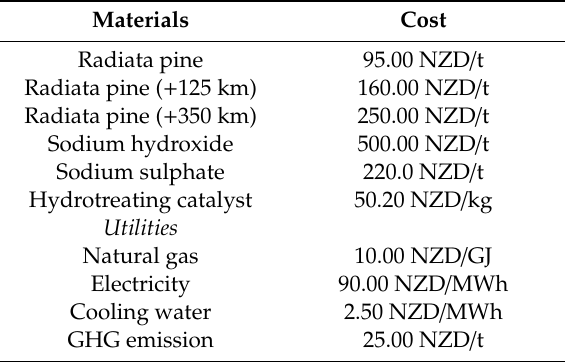
Table 1. Estimated material, utility, and carbon emission prices.